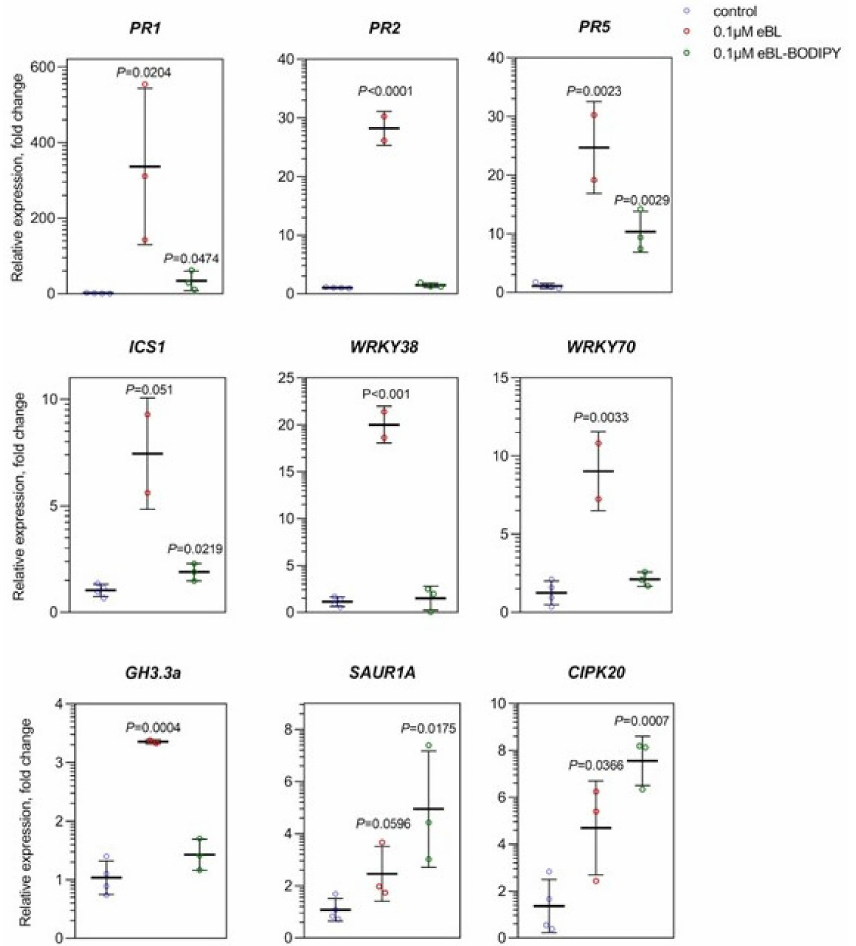
Figure 5. Effect of eBL and eBL-BODIPY on the transcription of selected genes, associated with salicylic acid (SA), auxin, and abscisic acid (ABA) responses. Five-day-old seedlings were exposed to 0.1 µ M of eBL or eBL-BODIPY for 24 h prior to RNA extraction. The p -value indicated for variants significantly different from control, t -test, n = 3–4, p <